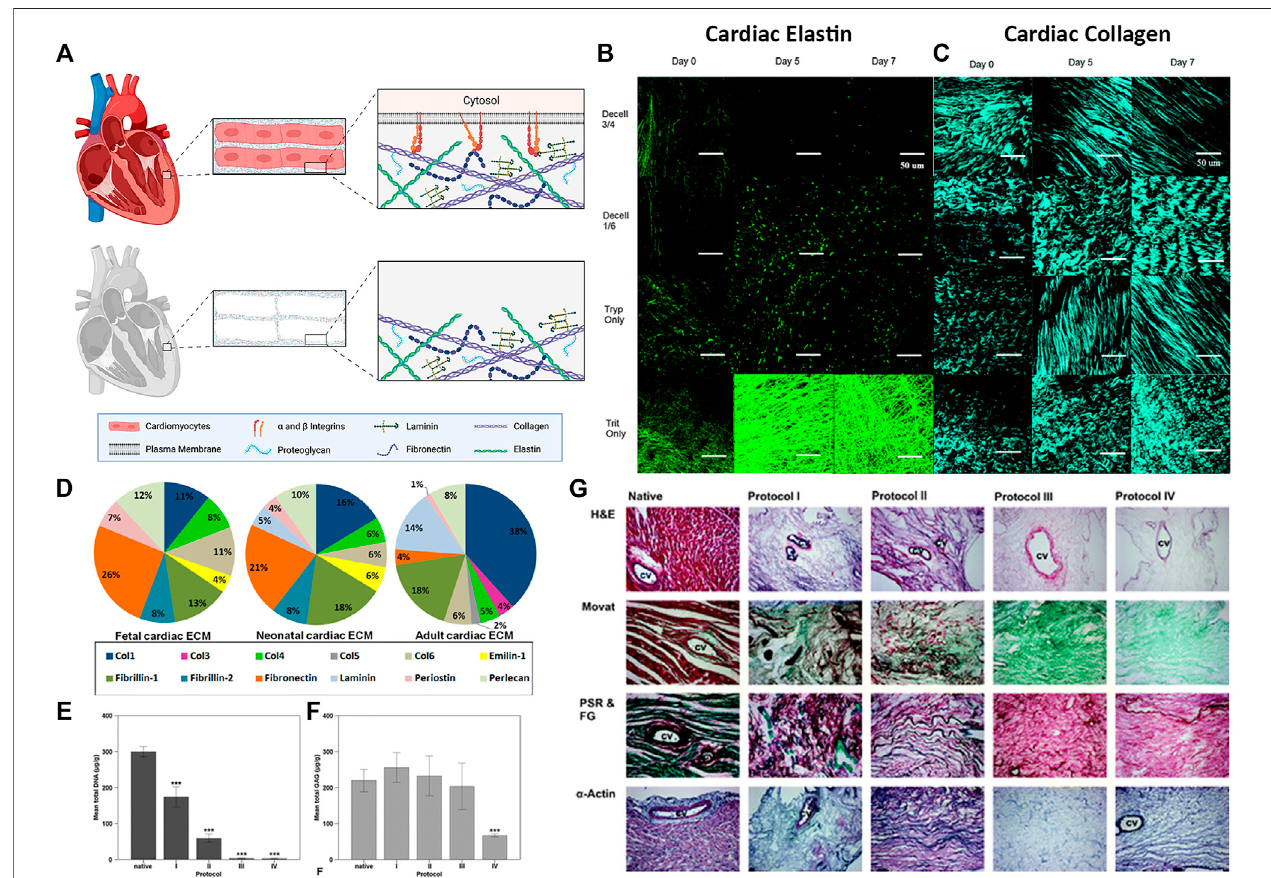
FIGURE 3 | Cardiac extracellular matrix composition (A) Schematic of cardiac tissue before and after decellularization (B – C) Extracellular matrix microstructure of decellularized whole porcine hearts following four different decellularization protocols. Decell 3/4: Trypsin for 3 days followed by Triton for 4 days. Decell 1/6: Trypsin 1 day, Triton 6 days. Tryp Only: Trypsin 7 days. Trit Only: Triton 7 days. Scale bar 50 µm (B) Elastin microstructure. Two photon fl uorescence (C) Collagen microstructure. Second harmonic generation imaging (D – F) Rat myocardial ECM morphology and composition before (native) and after whole heart decellularization using four different decellularization protocols. Brie fl y, Protocol I: SDS and Triton. Protocol II: Trypsin, EDTA, deoxycholic acid (DCA), and acetic acid. Protocol III: Glycerol,